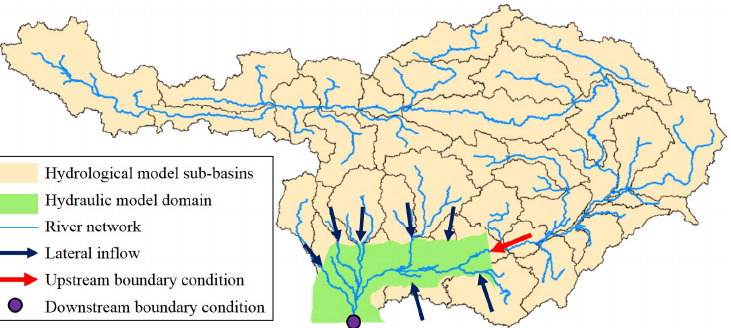
Figure 3. Representation of the sub-basins of the hydrological model and the domain of the hydraulic model (last 500 km of the river). Outflow from the hydrological model are considered both as lateral inflow (from 8 sub-basins) and upstream boundary condition (inflow contribution from 31 sub-basins) to the hydraulic